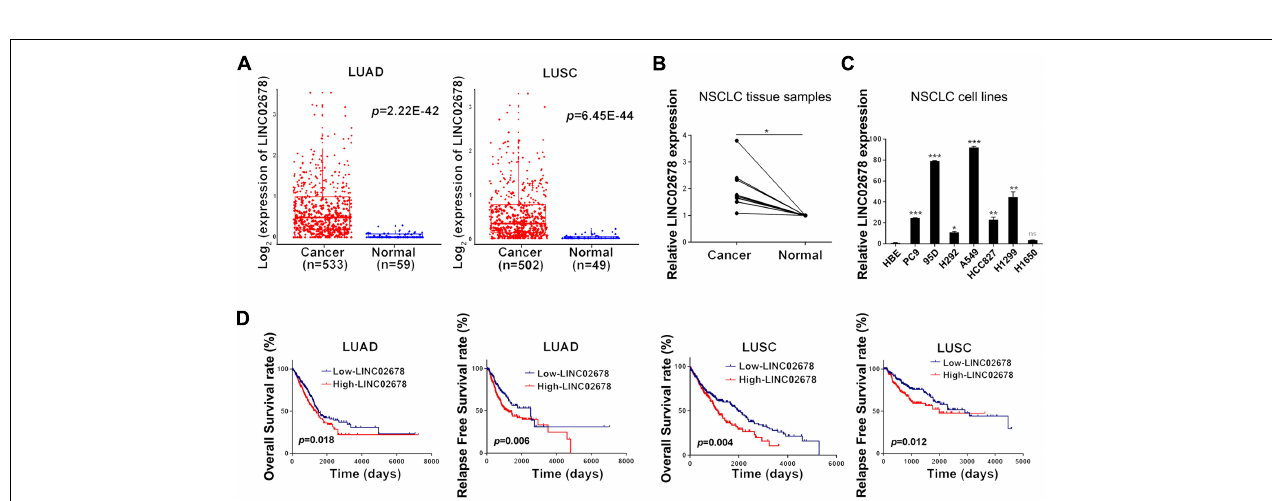
FIGURE 2 | LINC02678 acts as a differentially expressed tumor promotor lncRNA. (A) The expression level of LINC02678 in human LUAD, LUSC tissues and normal lung samples. (B) LINC02678 expression in the paired lung tissues measured by RT-qPCR. (C) LINC02678 expression in normal bronchial epithelial cell line HBE and NSCLC cell lines measured by RT-qPCR. (D) Kaplan-Meier analysis of OS and RFS of LINC02678 in LUAD and LUSC. (* p < 0.05; ** p < 0.01; *** p < 0.001. Data were obtained from three independent experiments).